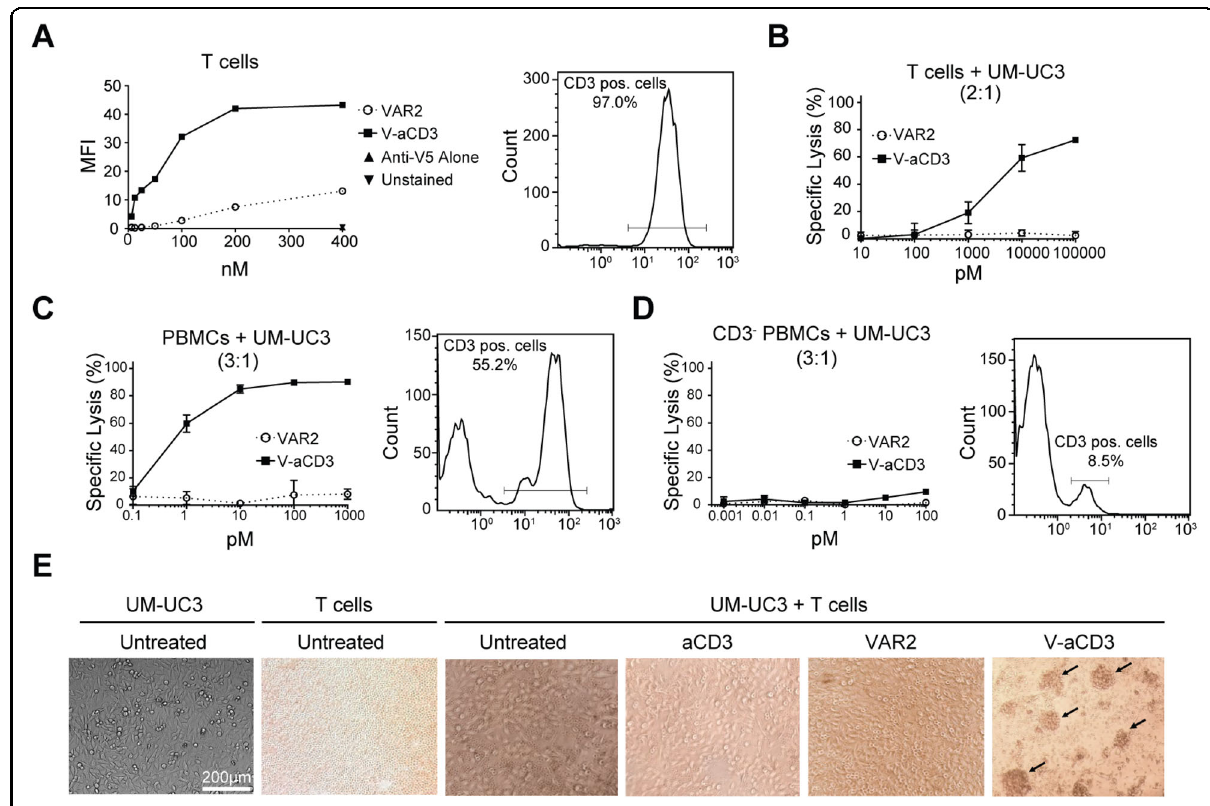
Fig. 3 V-aCD3 bind to T cells and induces T-cell-mediated cancer cell death. A Binding of V-aCD3 (solid line) and of rVAR2 (dashed line) to puri fi ed T cells was assessed by fl ow cytometry and showed binding of V-aCD3 to T cells at low concentrations. Above 95 percent of the puri fi ed PBMCs was CD3-positive. B V-aCD3 mediated killing in the presence of T cells. C V-aCD3 mediated killing in the presence of PBMC. About 50% of the PBMC was positive for CD3. D V-aCD3 mediated killing in the presence of PMBC depleted of T cells. V-aCD3 (solid lines) and rVAR2 alone (dashed lines) Blood donors = 3 for each of the above experiment. Each data point represent the mean of triplicate wells. Error bars show standard error of the mean. E Pictures of suspensions of UC-3 cancer cells and T cells (upper panel), mixtures of these cell in the presence of cell medium, aCD3, rVAR2 or V-aCD3 (middle and lower panel). The mix of T cells and cancer cells in the presence of V-aCD3 induces cell cluster